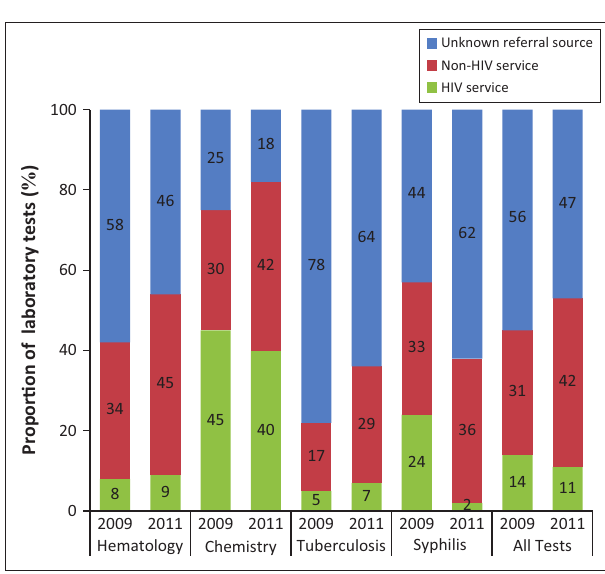
(Table 2; Figure 2). The proportion of haematology tests